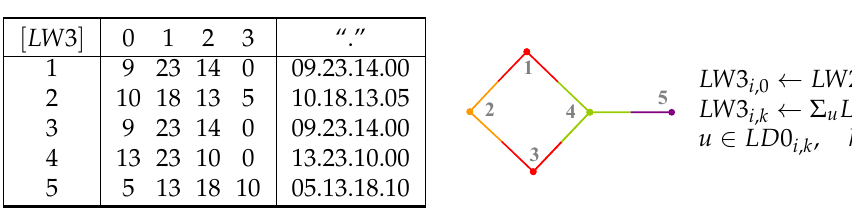
Figure 13. [ LW 2 ] on Figure 1.